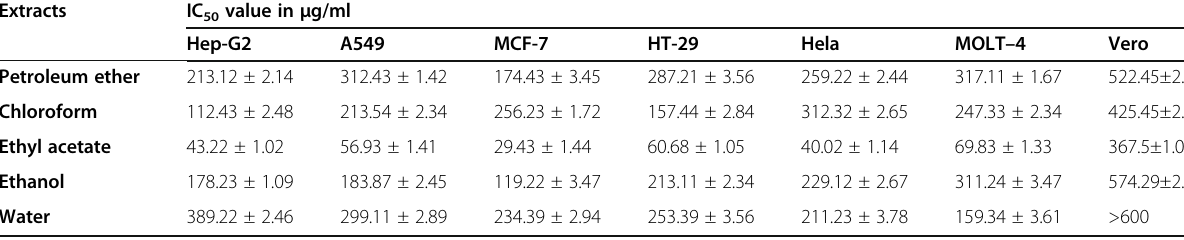
Table 3 IC 50 of different solvent extracts of Clerodendrum thomsoniae Balf on different cell lines Extracts IC 50 value in μ